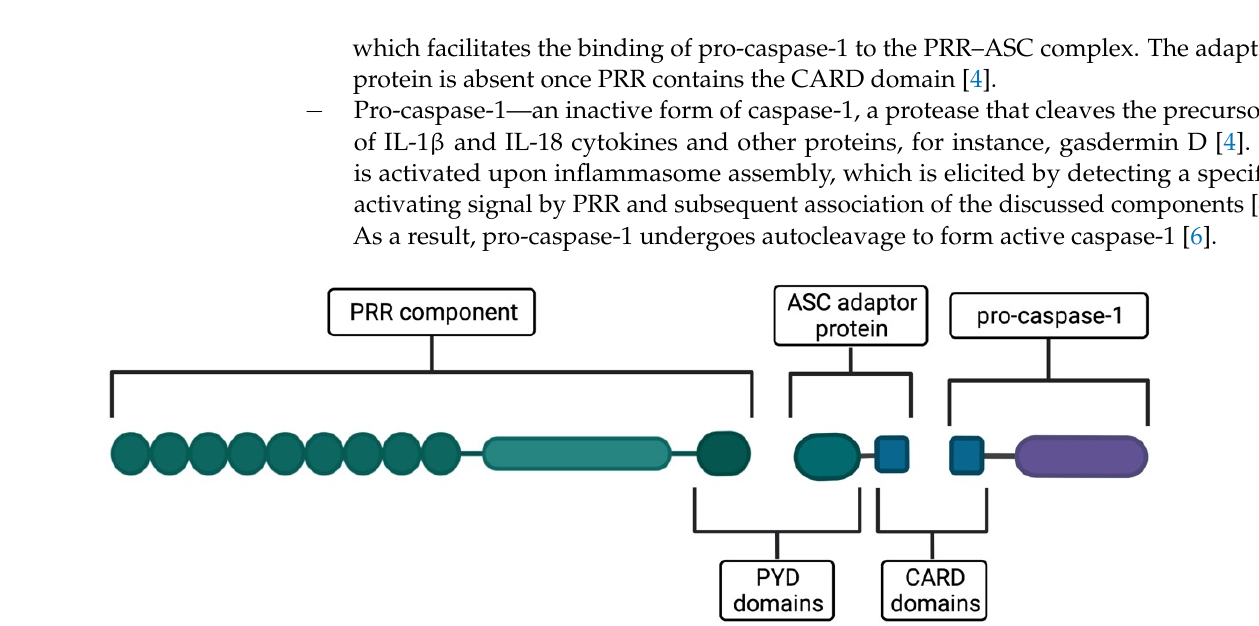
Figure 1. The components of the inflammasome complex—A general scheme. PRR—A component that detects inflammasome activation signals. ASC—An adaptor protein enabling association of PRR with pro-caspase-1. Pro-caspase-1—An effector component of the inflammasome complex. PYD domains—Domains enabling the association of PRR with ASC. CARD domains—Domains enabling the association of pro-caspase-1 with the PRR–ASC complex. Abbreviations: PRR—Pattern- recognition receptor; ASC—Apoptosis-associated speck-like protein containing a caspase-recruitment domain; PYD—Pyrin domain; CARD—Caspase activation and recruitment domain. Created with BioRender.com (accessed on 10 May 2022).